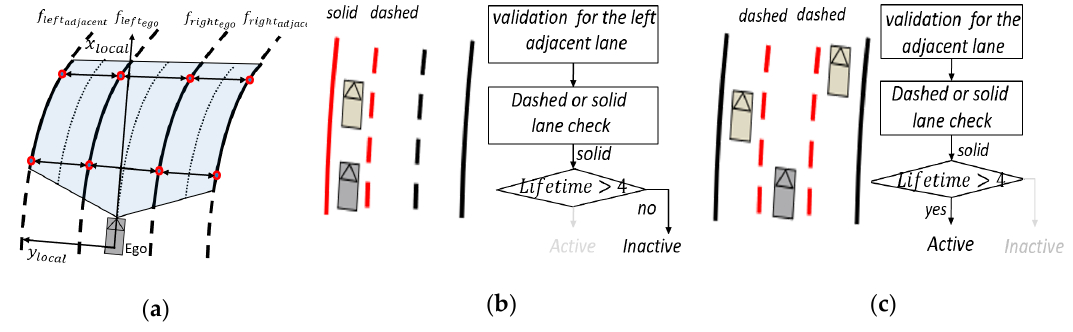
Figure 8. Lane track management, ( a ) subject multi-lane ( left ego , right ego , left adjacent , right adjacent ), ( b , c ) two cases of adjacent left lane with lane validation logic.